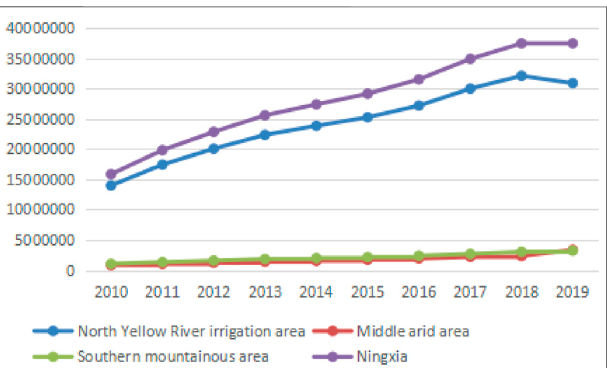
Frontiers in Environmental Science |